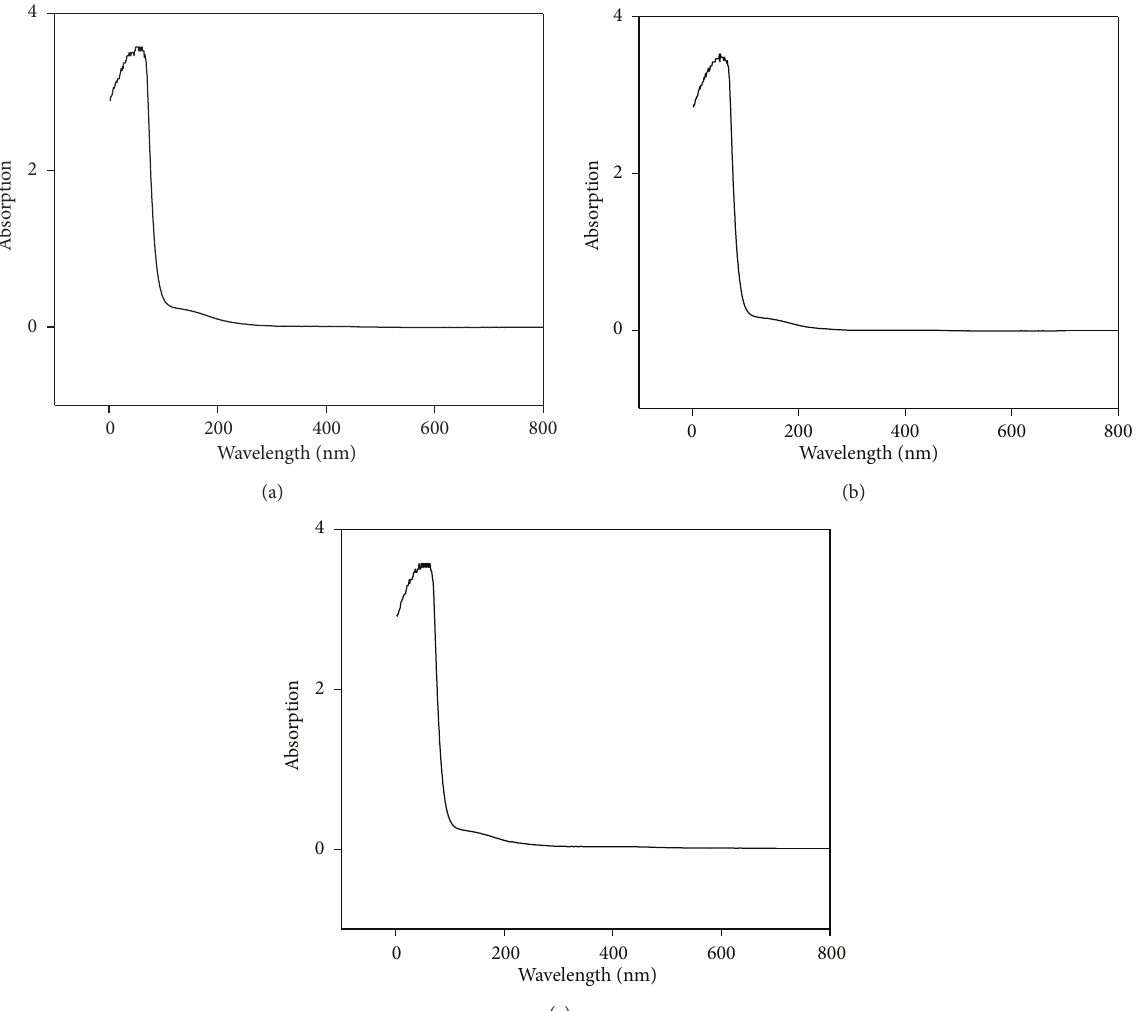
Figure 2: UV-Vis absorption spectra of (a) TGSP, (b) TGSP + ADP, and (c) TGSP + KDP